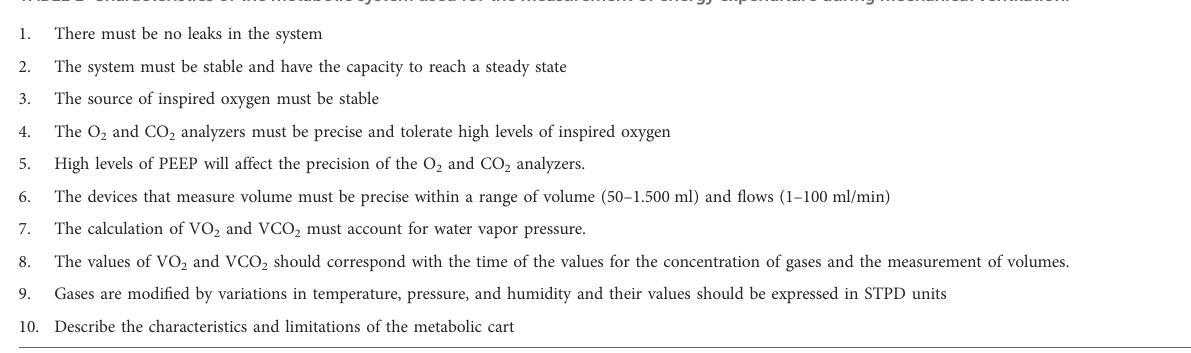
TABLE 1 Characteristics of the metabolic system used for the measurement of energy expenditure during mechanical